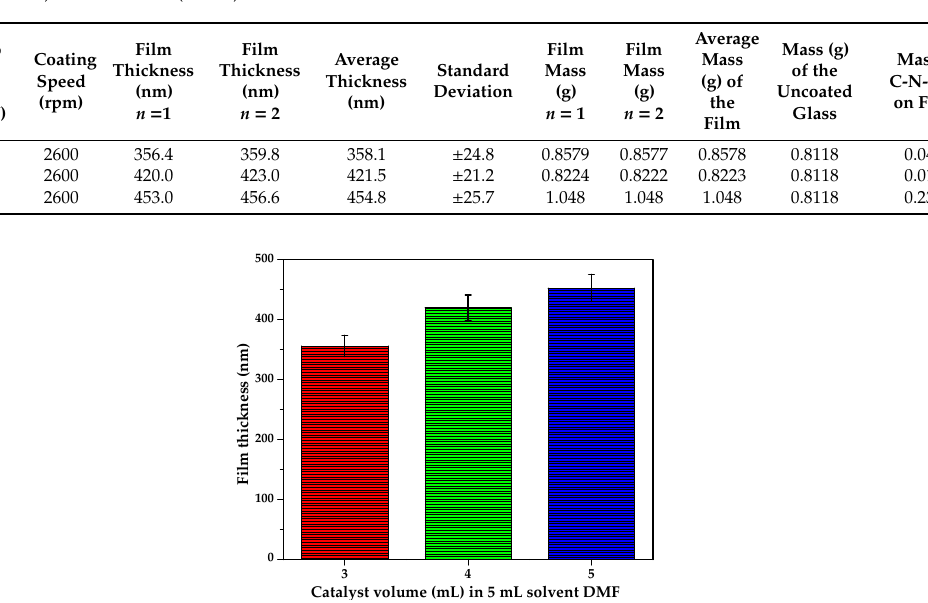
Table 4. Effect of sol gel to solvent volume ratio ( V : V ) on the film thickness. Experimental conditions: 10 °C/min) for 105 min ( n = 2).